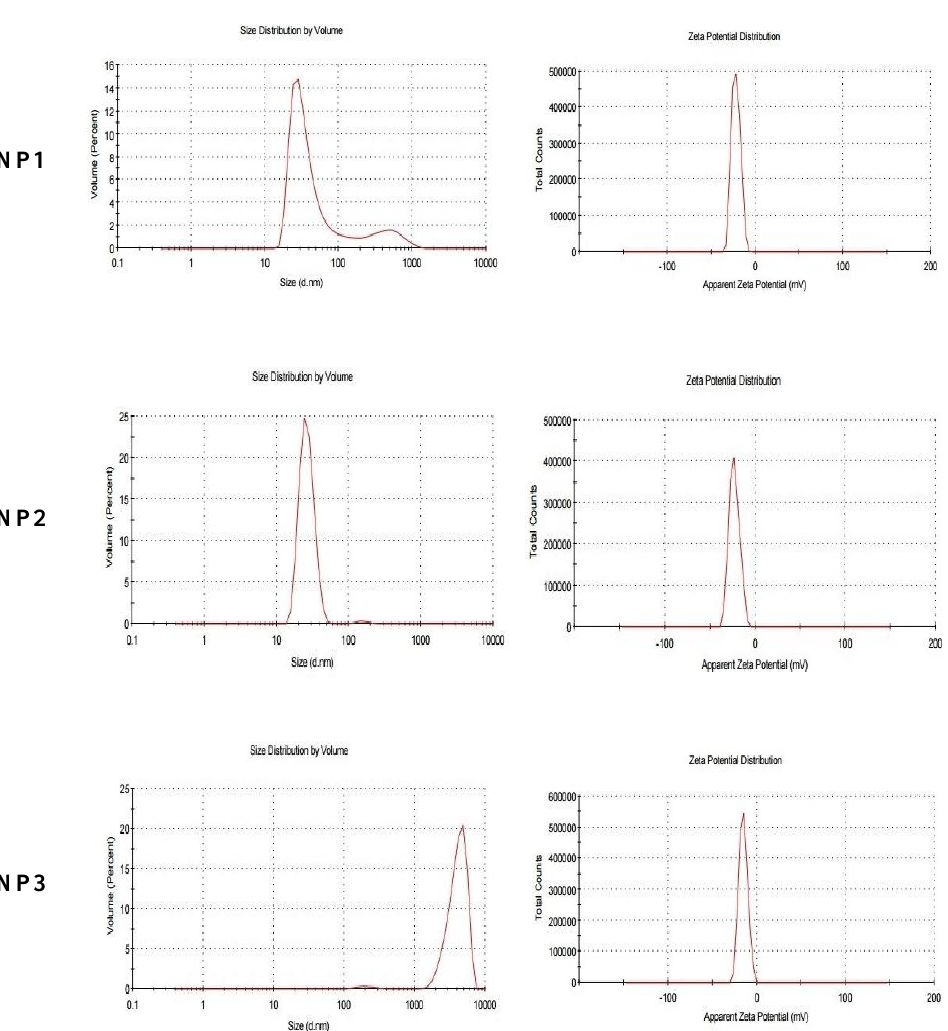
Figure 1. The particle size and zeta potential of the prepared DOXY-PNPs.